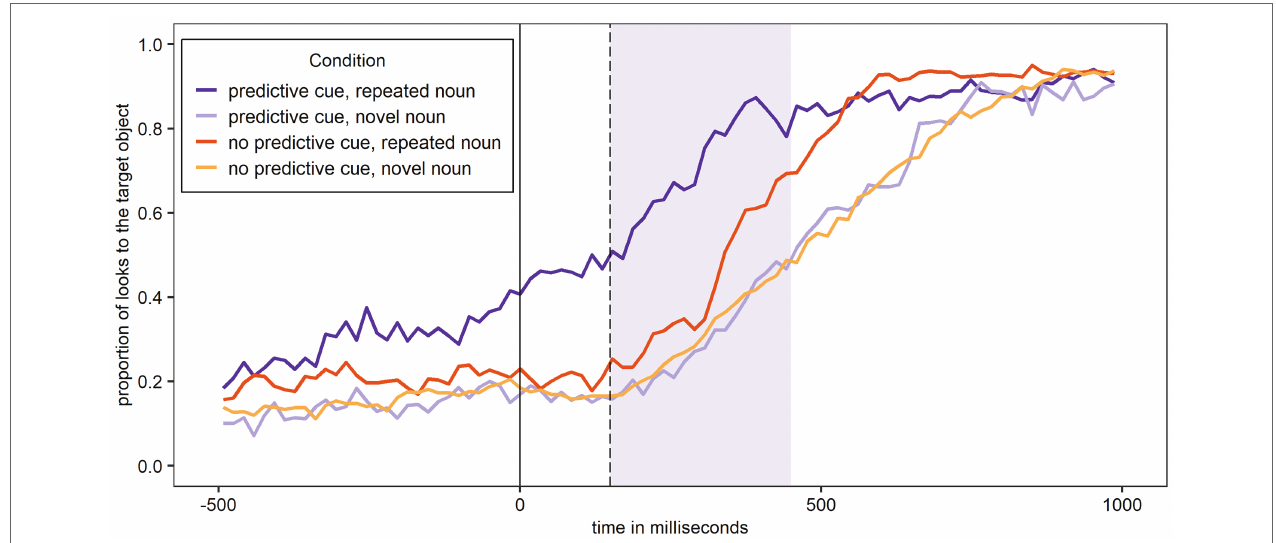
FIGURE 6 | Proportion of looks over time to the target object across conditions in English (L2) after the training phase. The shaded area corresponds to the analysis window.